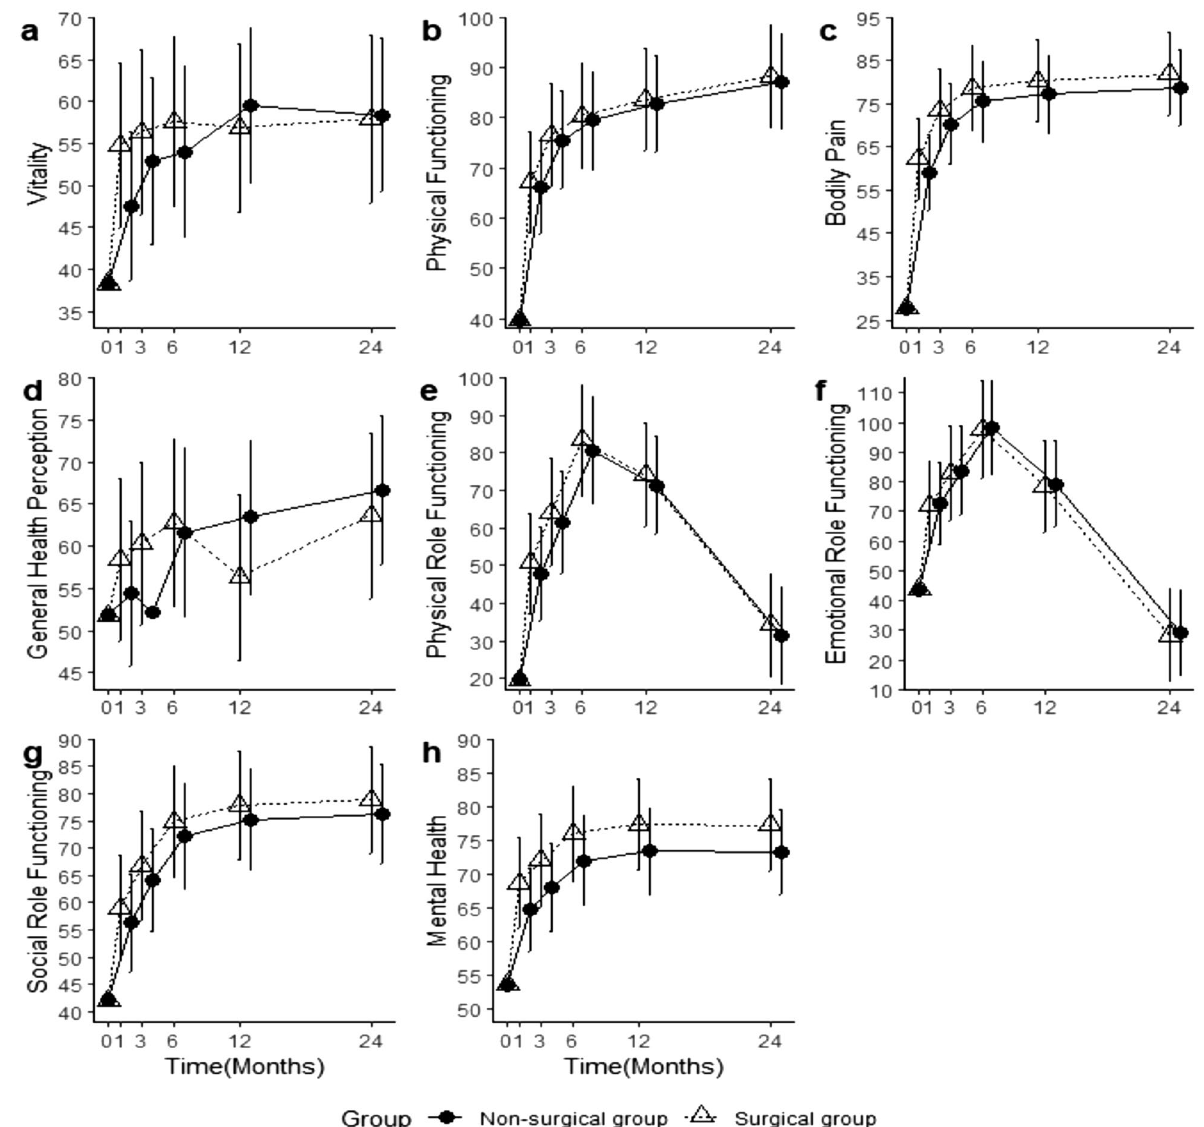
Figure 4. 36-Item Short-Form Health Survey (SF-36) outcomes. The adjusted means and confidence intervals estimated from mixed effect models for 36-Item Short-Form Health Survey (SF-36) outcomes; ( a )